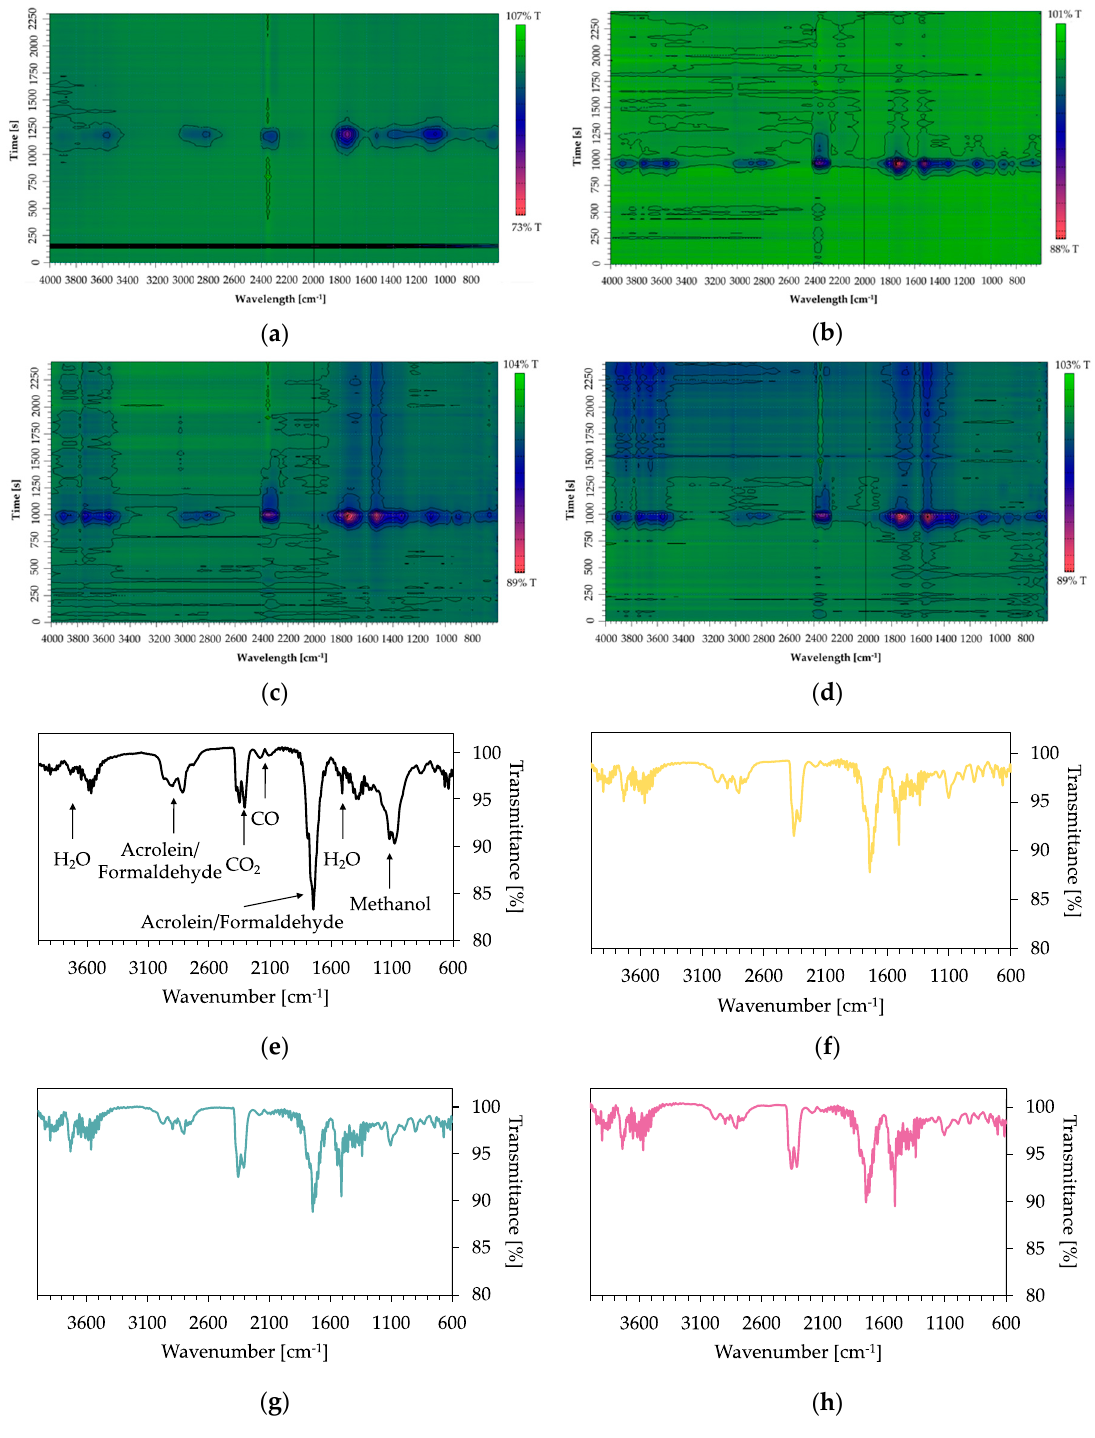
Figure 7. 2D plots and FTIR-spectra of the corresponding peak maxima of uncoated and coated cotton fabrics, obtained by TGA-FTIR investigations in nitrogen. ( a ) 2D plot of uncoated cotton; ( b ) 2D plot of 5 BL; ( c ) 2D plot of 10 BL; ( d ) 2D plot of 15 BL; ( e ) spectrum at 1180 s (393 ◦ C in TGA) of uncoated cotton; ( f ) 5 BL spectrum at 970 s (323 ◦ C in TGA); ( g ) 10 BL spectrum at 1000 s (333 ◦ C in TGA); ( h ) 15 BL spectrum at 980 s (327 ◦